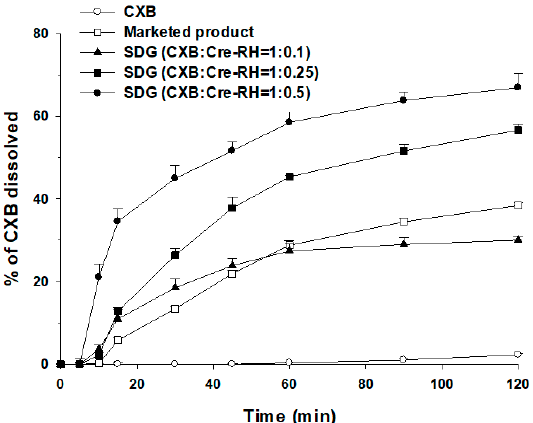
Figure 3. Dissolution profiles of CXB in pH 1.2 medium at 37.0 ± 0.5 °C from CXB, the marketed product (Celebrex ® ), and SDGs with different weight ratios of CXB/Cre-RH ( n = 3).